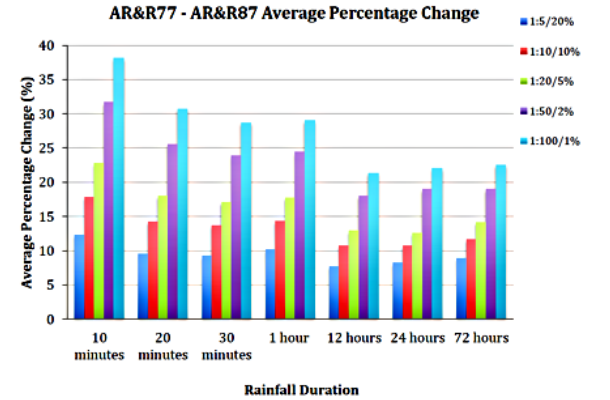
Figure 2. Average percentage change in rainfall intensities between AR&R77 and